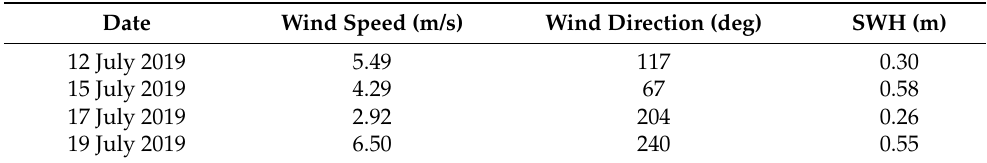
Figure 2. ( a ) GPS satellites’ sky plot at Cap Gris-Nez on 17 July 2019. ( b ) Experiment location and flight trajectory from Calais to Boulogne-sur-Mer. The flight trajectory consisted of two legs, one at 700 m from the coastline and the second at 2000 m. Table 1. Sea-state parameters during the measurement campaign.